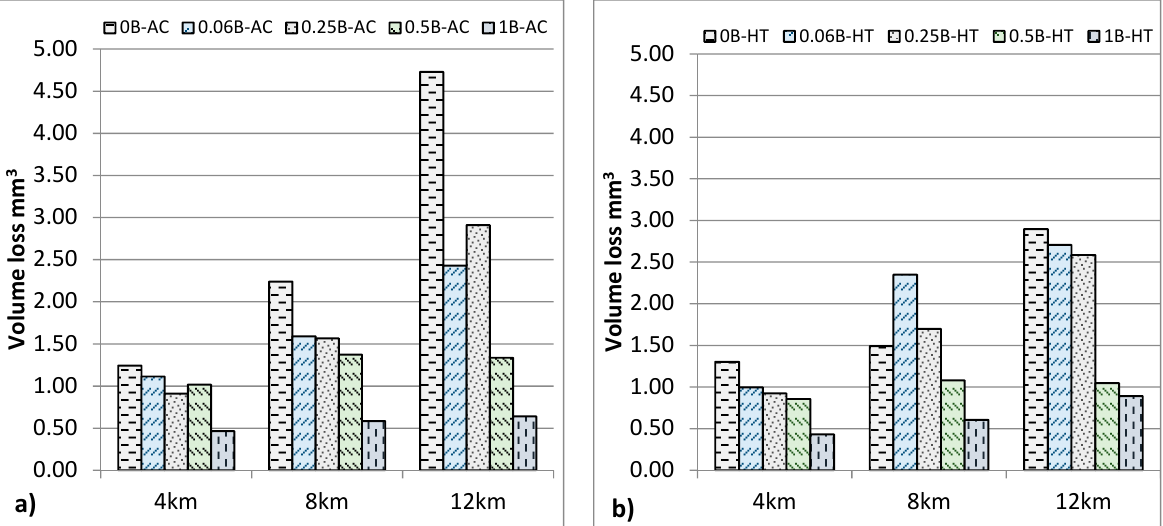
Figure 5. Wear volume of alloys with different boron content according to sliding distance; ( a ) as-cast alloys and, ( b ) heat- treated alloys.